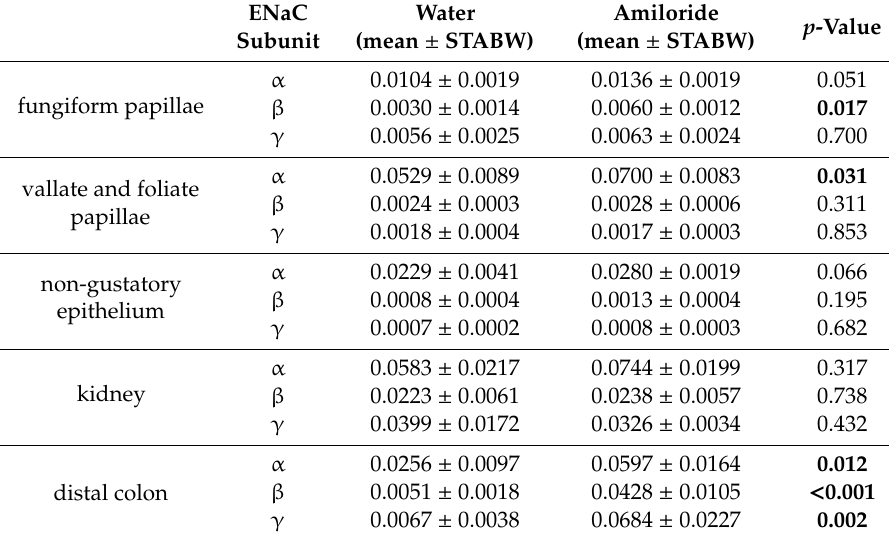
Table 2. Relative expression of ENaC subunits in Scnn1 aa / bb mice after amiloride intervention. Based on quantitative RT-PCR the relative expression levels of ENaC subunits normalized to the housekeeping genes β -actin and eEf2 in isolated taste buds and non-gustatory tissue were determined. Data represent means of 6 Scnn1 aa / bb mice, with access to a sodium-adequate diet and water or 300 µ M amiloride-containing drinking solution for 36 h prior to tissue isolation. Statistical testing was based on Student´s t -test. Di ff erences were considered to be significant if p < 0.05, as indicated in